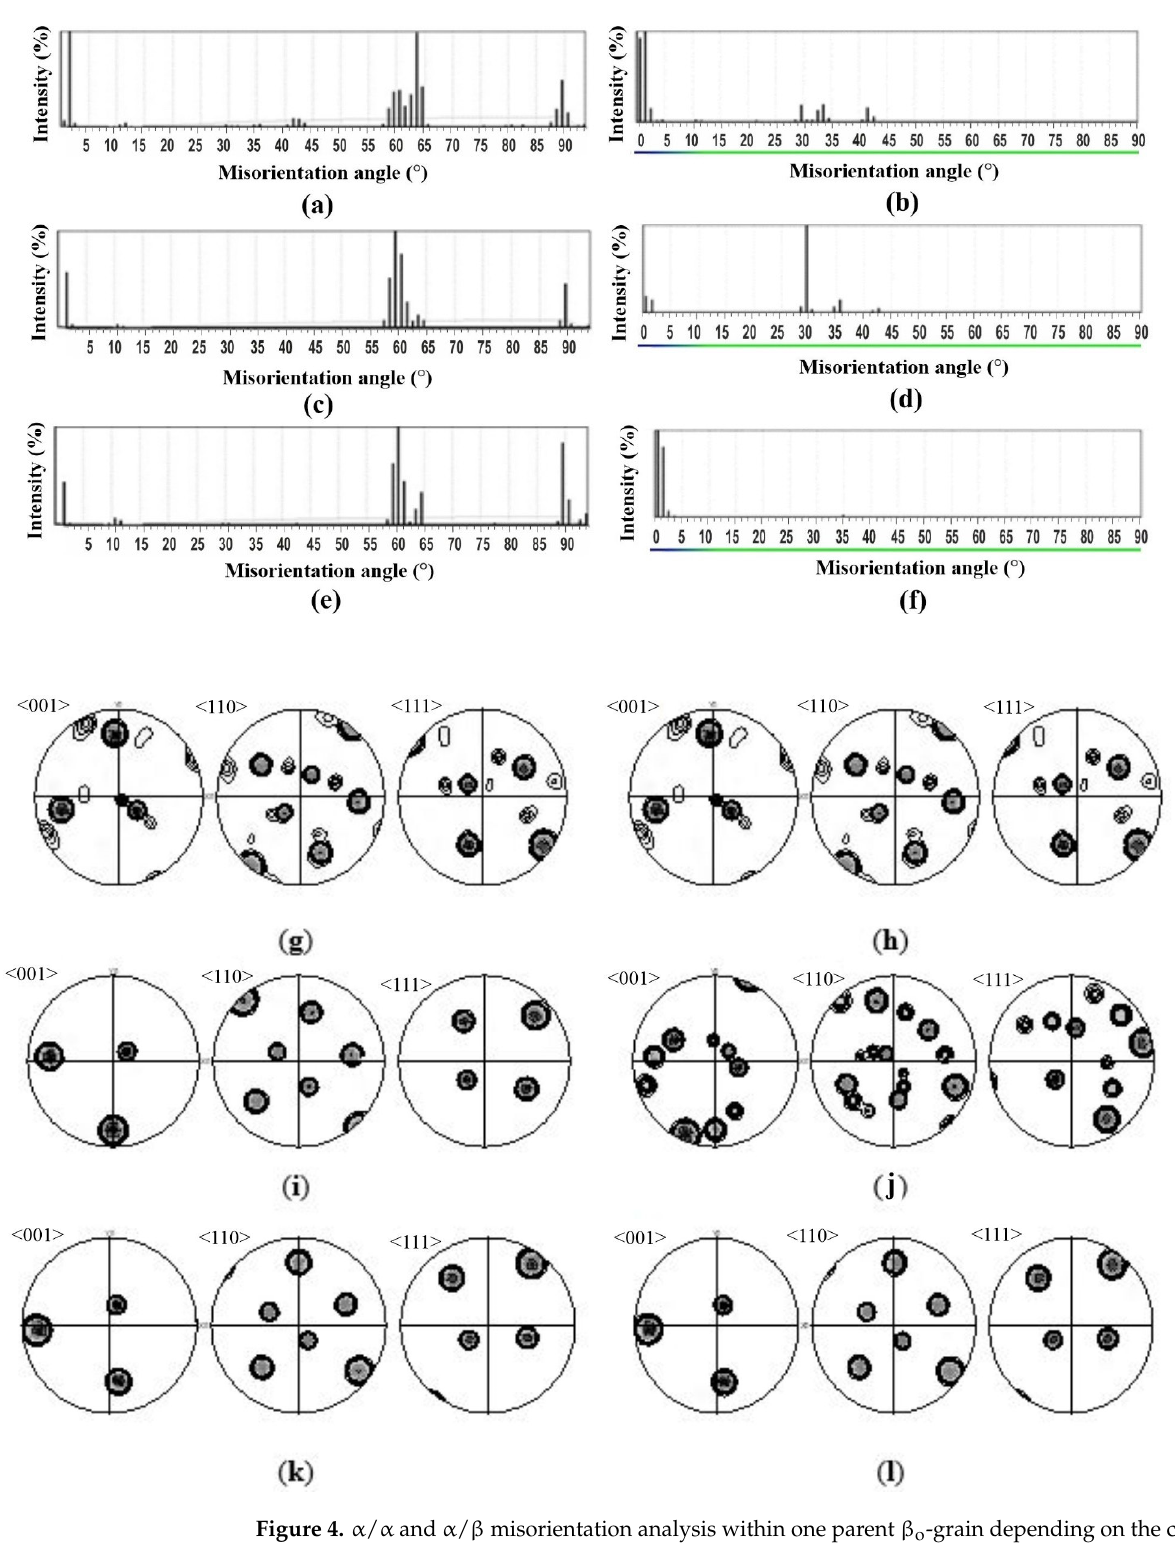
Figure 4. α / α and α / β misorientation analysis within one parent β o -grain depending on the cooling rate: ( a , c , e ) the misorientation angle distribution in the α -phase for WQ, AC, FC; ( b , d , f ) spectra of deviation from BOR for WQ, AC, FC; ( g , i , k ) <001>, <110>, <111> pole figures of the reconstructed β o -phase for WQ, AC, FC; ( h , j , l ) <001>, <110>, <111> pole figures of β -phase after WQ, AC,